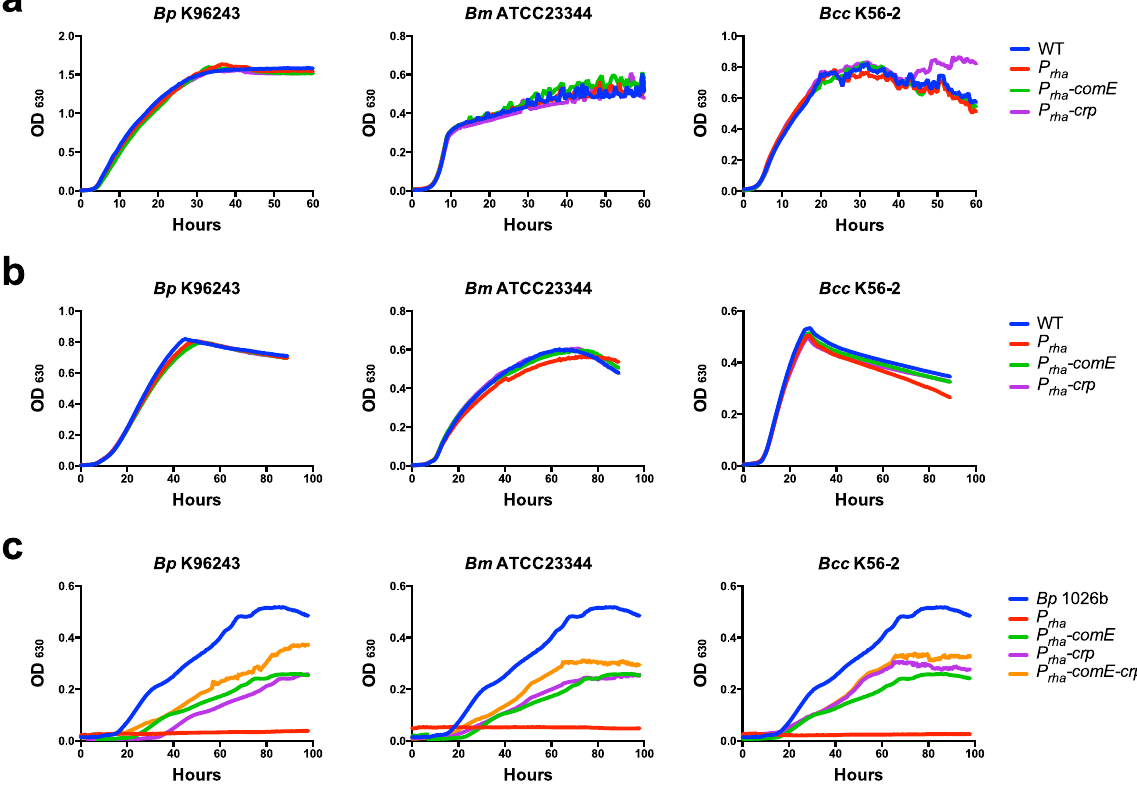
Figure 1. In vitro growth characteristics of Bp K96243, Bm ATCC23344 and Bc K56-2. Site-specific recombination at the attTn7 site was used to insert comE , crp , or comE-crp driven by the rhamnose-inducible promoter ( P rha ). All strains were tested at 37 °C while shaking in LB (a) , M9 minimal media supplemented with 20 mM glucose (b) , or minimal media supplemented with 0.1% purified salmon sperm DNA (c) . All media contained 0.2% rhamnose to express genes inserted in the attTn7 site. The naturally competent Bp 1026b is shown as a point of reference for growth on DNA as a sole carbon source (c)